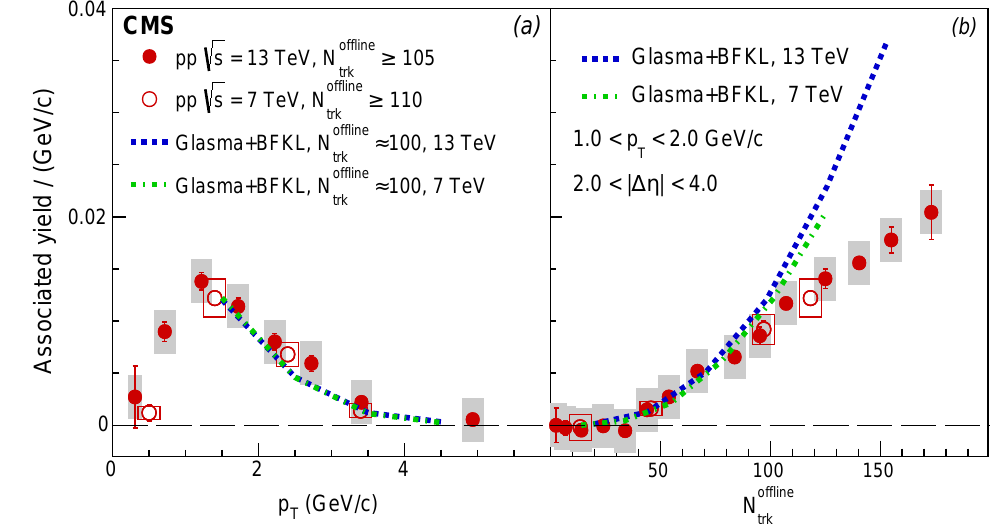
Figure 28. The 2-D two-particle correlation functions for p + p at events with p T > 0.1 GeV/c; ( b ) minimum bias events with 1 < p T < 3 GeV/c; ( c ) high multiplicity ≥ 110) events with p ( N offline T > 0.1 GeV/c; and ( d ) high multiplicity ( N trk 1< p T < 3 GeV/c. The sharp near-side peak from jet correlations is cut off in order to better illustrate the structure outside that region. Reproduced from Ref. [369].